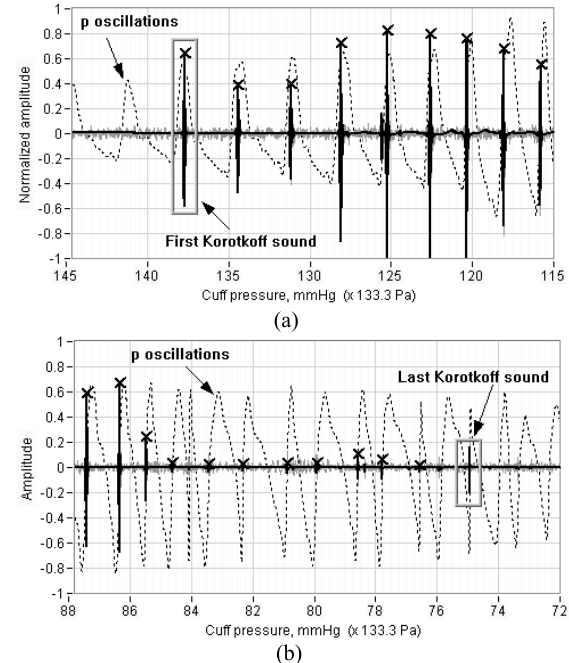
Fig. 6. Detection of the first and last Korotkoff sounds.